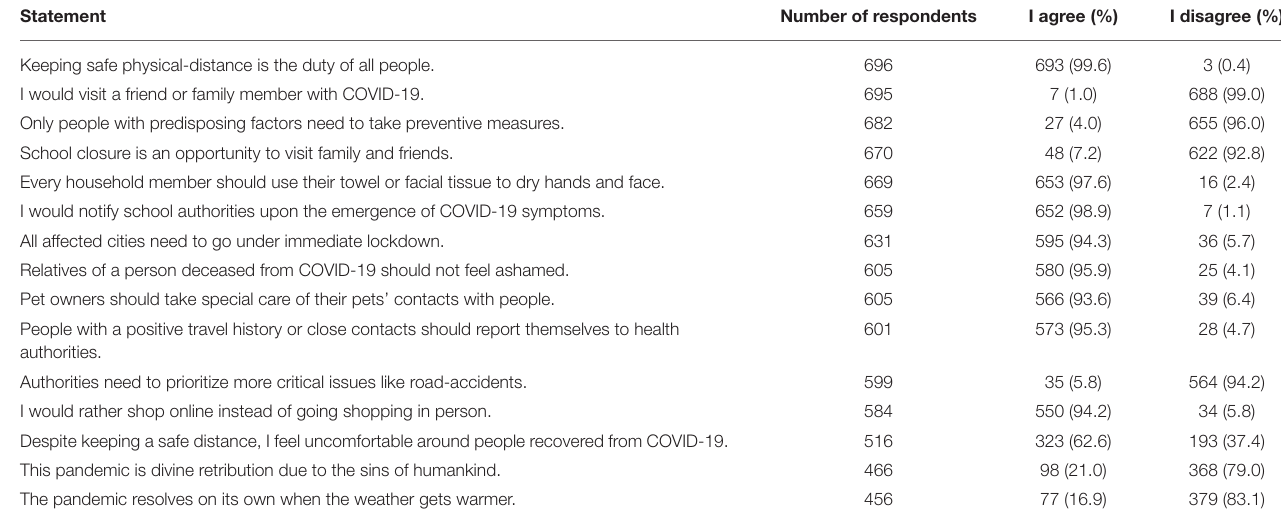
TABLE 5 | Attitudes of participants toward